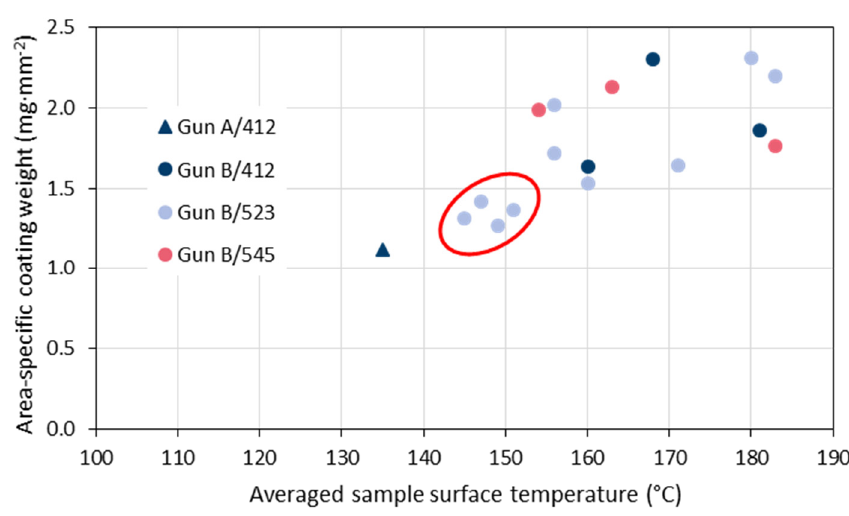
Figure 11. Area-specific coating weights plotted against the averaged sample surface temperature observed in 2020 and 2021; the legend indicates the gun in use and the designation of the powder batch.